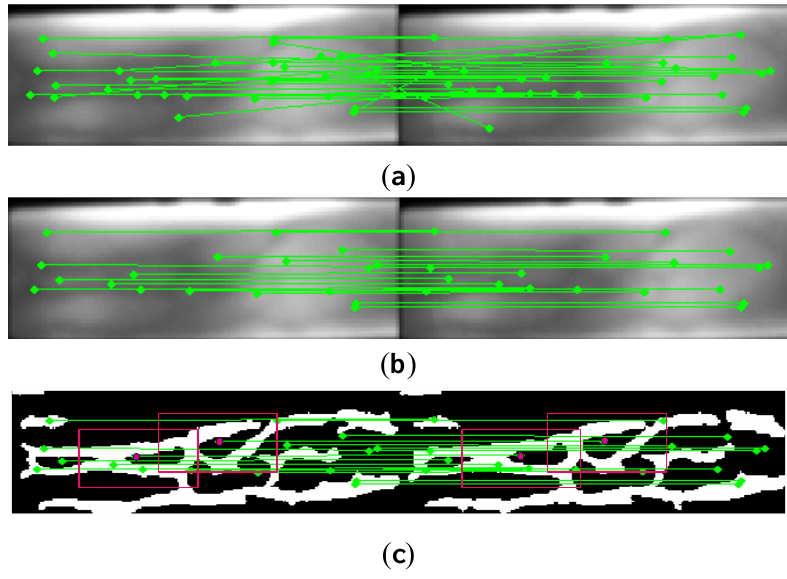
Figure 3. Matching results of SIFT features for finger-vein images from a same person. ( a ) Feature points obtained by original SIFT method; ( b ) Feature points obtained by improved method; ( c ) The sub-regions for two pairs of matching